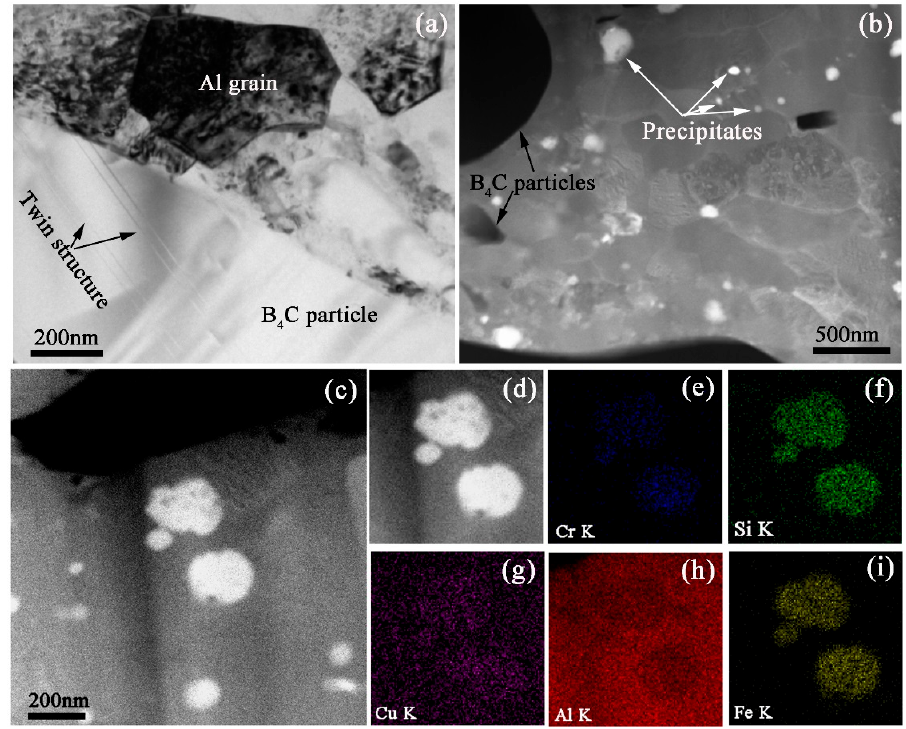
Figure 4. ( a ) Bright field TEM image and ( b ) Low magnification high angle annual dark field scanning transmission electron microscopy (HAADF-STEM) image of Al-30% B 4 C MMCs; ( c , d )